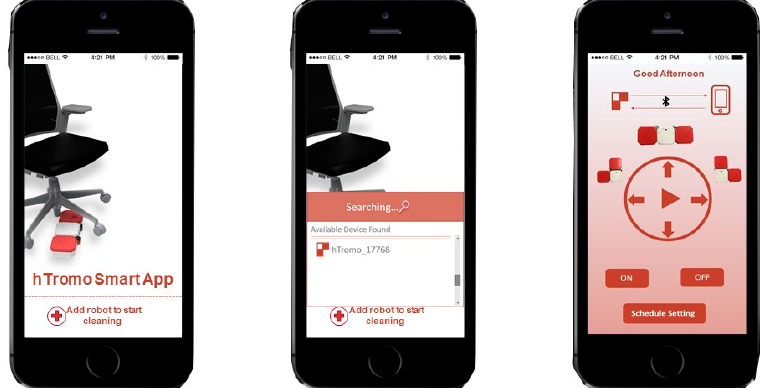
Figure 12. hTromo User Interface.